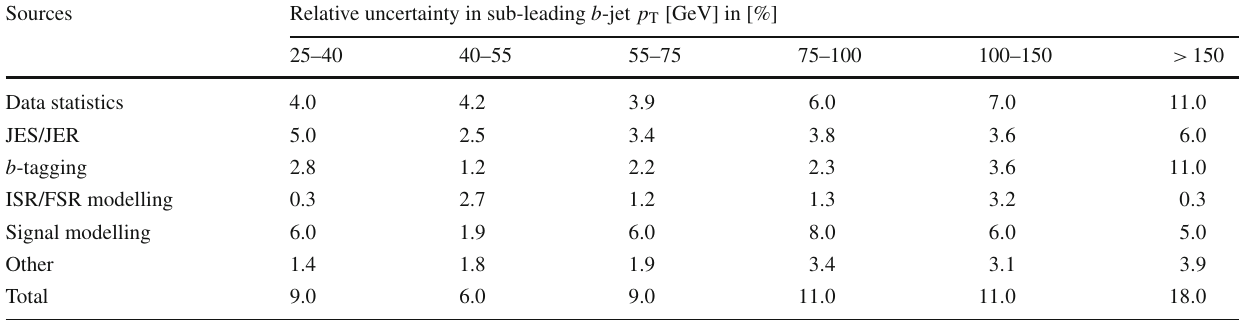
Table 8 Summary of relative measurement uncertainties in [%] for the sub-leading b -jet p T distribution. ¨ Signal modelling” sources of systematic uncertainty includes the hadronisation, parton shower and